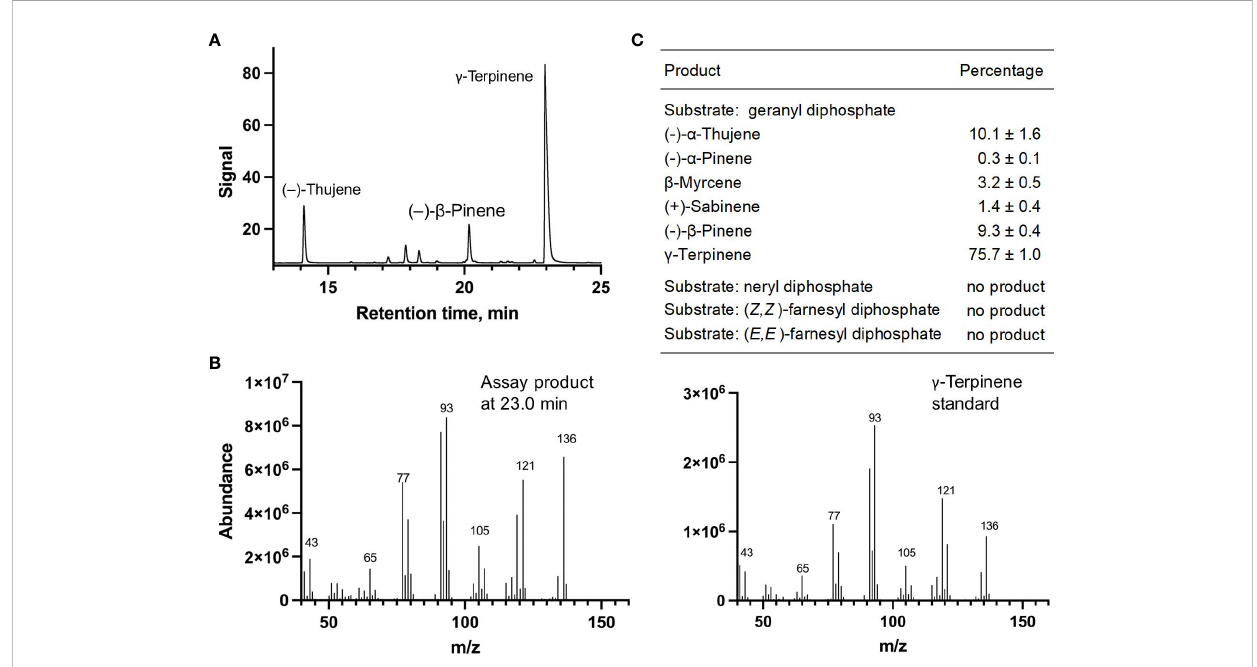
FIGURE 6 Characterization of M. longifolia CMEN 585 candidate Ml_14850. (A) GC chromatogram with annotation for major peaks; (B) mass spectrum of the main enzymatically generated product and the matching authentic standard ( g -terpinene); and (C) tabulated product pro fi